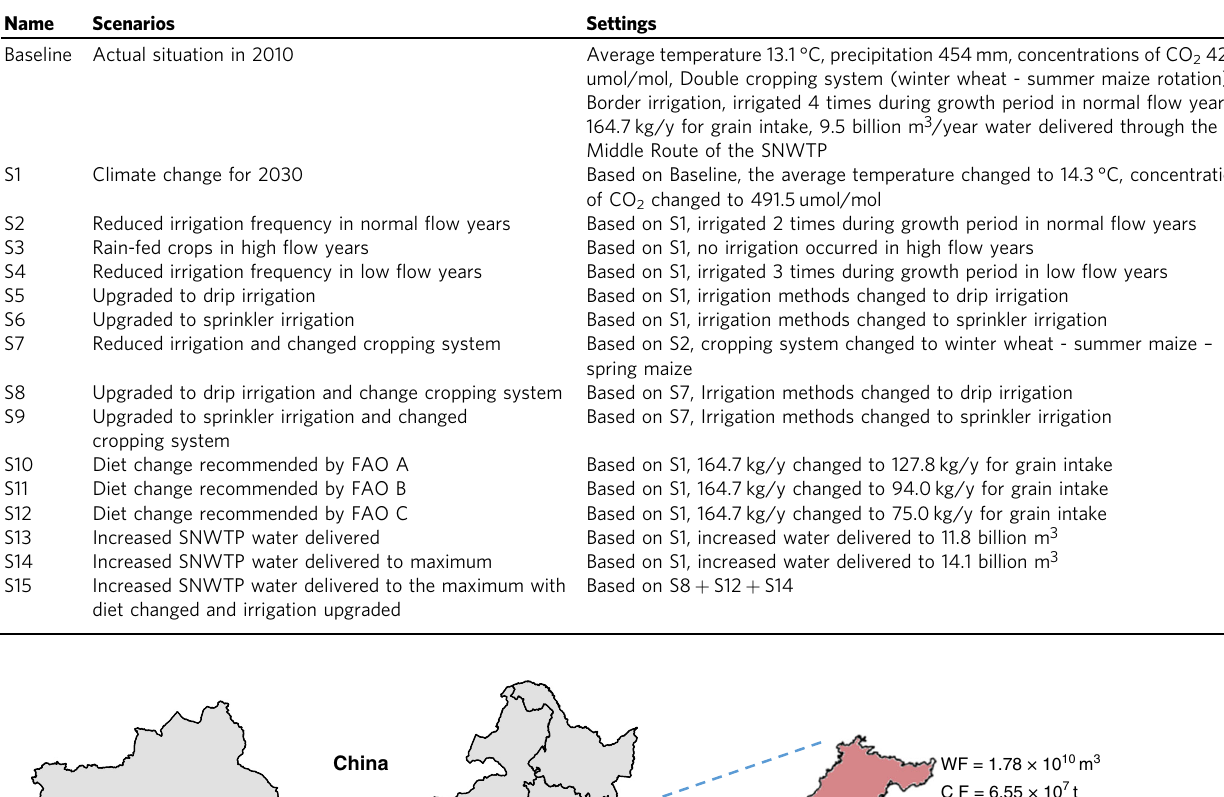
Table 1 Scenario settings for irrigated agriculture in the North China Plain.